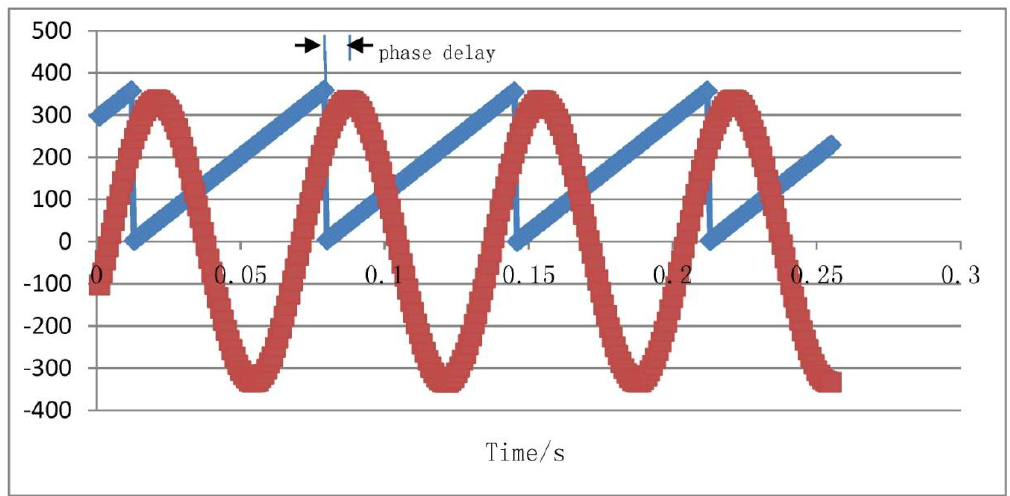
Figure 21. Phase delay comparison chart.